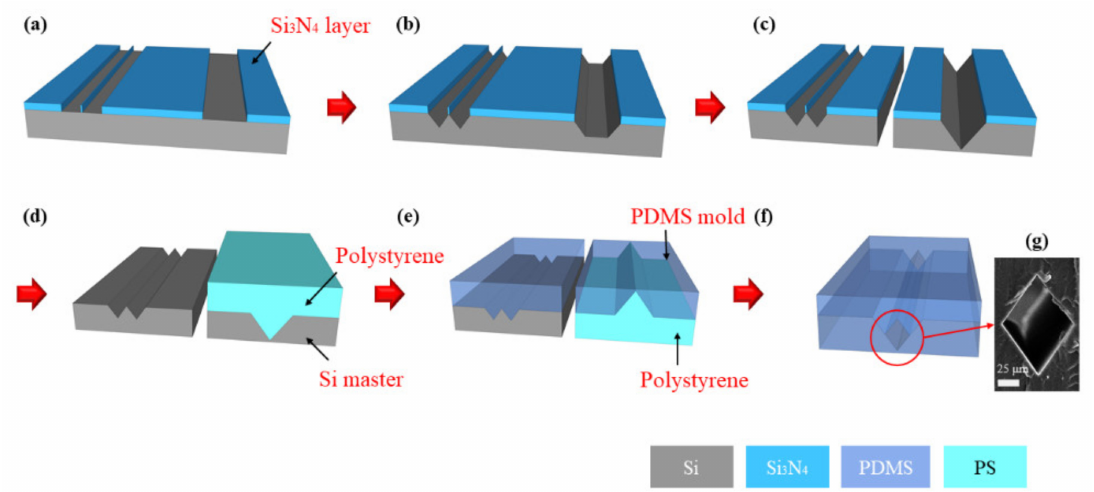
Figure 1. Schematic three-dimensional (3D) view of fabrication processes of the microchannel with a rhombic cross-sectional shape ( a – f ) and cross-sectional scanning electron microscope (SEM) image of fabricated rhombic microchannel ( g ). ( a ) Si 3 N 4 layer patterning; ( b ) Si wet etching; ( c ) dicing and additional wet etching of Si channel; ( d ) hot-embossing polystyrene(PS) after removal of Si 3 N 4 layer; ( e ) polydimethylsiloxane (PDMS) molding; ( f ) plasma bonding of PDMS; ( g ) PDMS rhombic microchannel with a side length of 73.5 µ